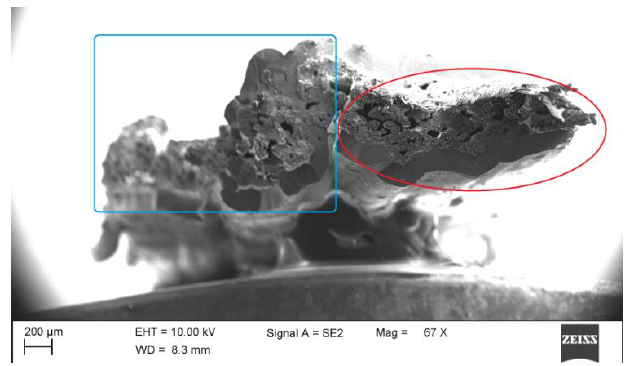
Materials 2021 , 14 , x FOR PEER REVIEW Figure 4. The fracture section of sample NC_2. Figure 4. The fracture section of sample NC_2.